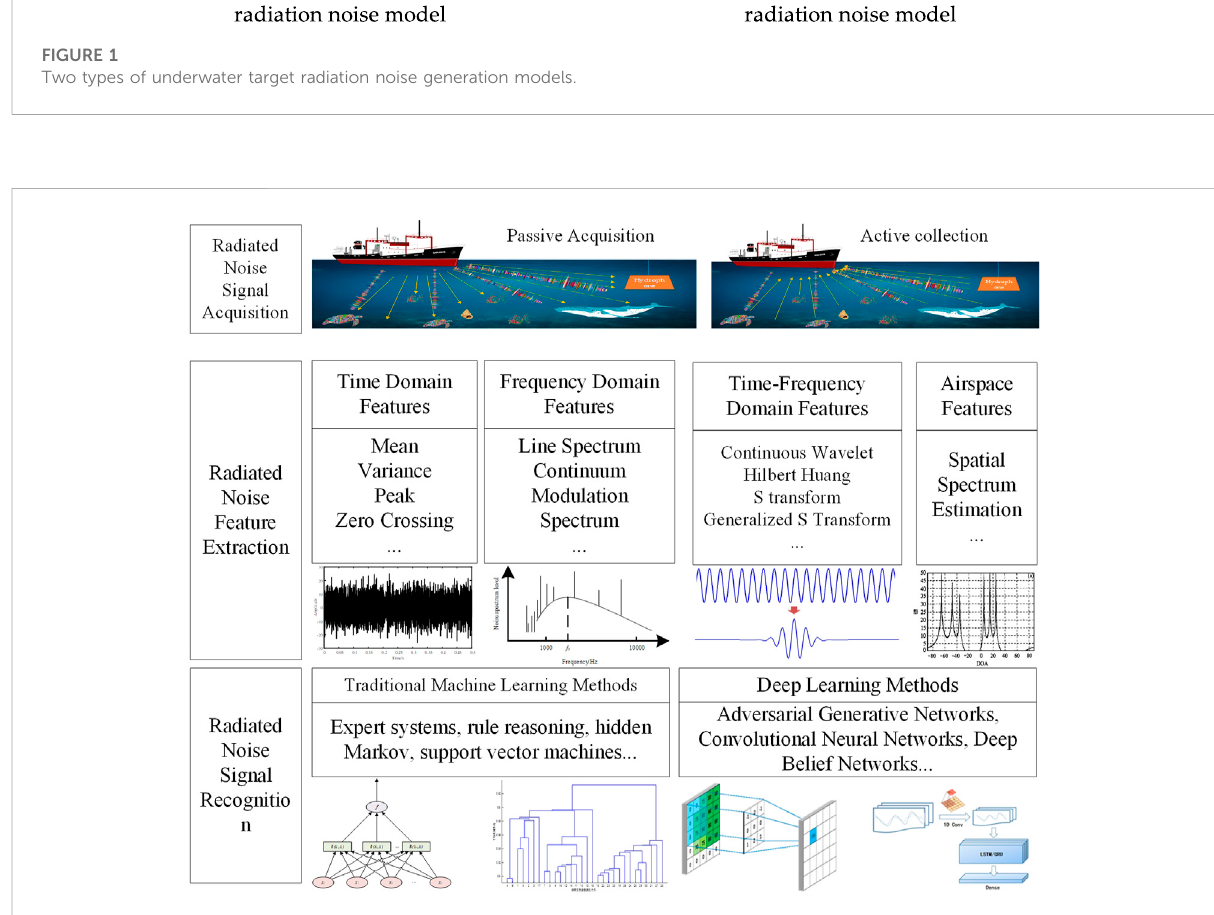
FIGURE 2 Flow chart of underwater target radiation noise recognition [4,